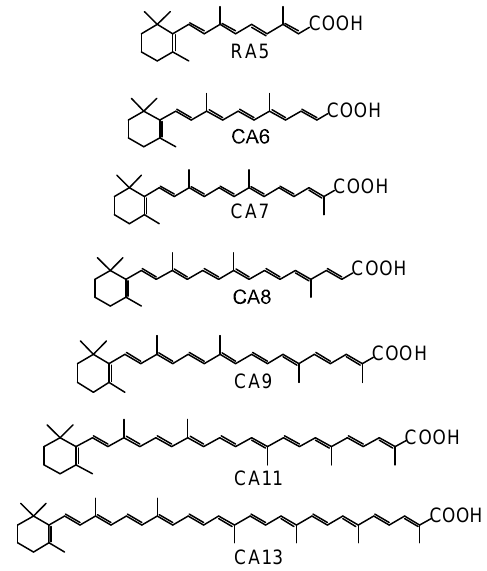
Figure 4. Chemical structures of retinoic acid (RA5) and carotenoic acids